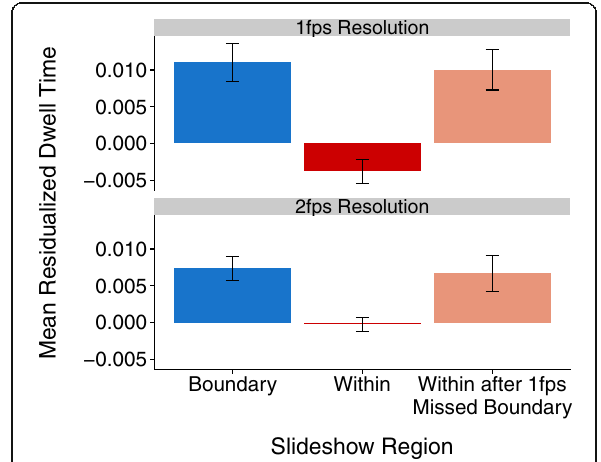
Fig. 3 Mean residualized dwell times (± standard error) to boundary slides, within-unit slides, and within-unit slides immediately after a boundary that was missed in the 1-fps slideshows (but present in the 2-fps slideshows). fps frames per